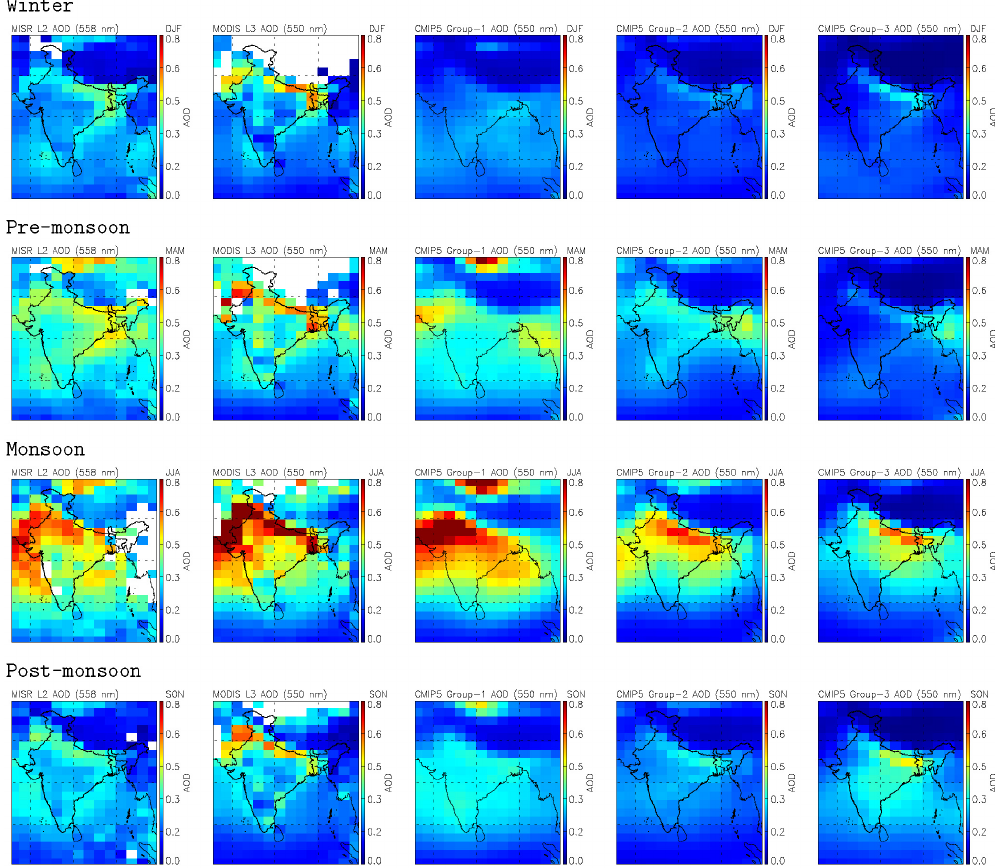
Figure 4. Seasonal variation of AOD for 2000–2005 derived from MISR, MODIS, and the three model groups defined in the text. The seasons have been defined as monsoon (June, July, August), post-monsoon (September, October, November), winter (December, January, February), and pre-monsoon (March, April,